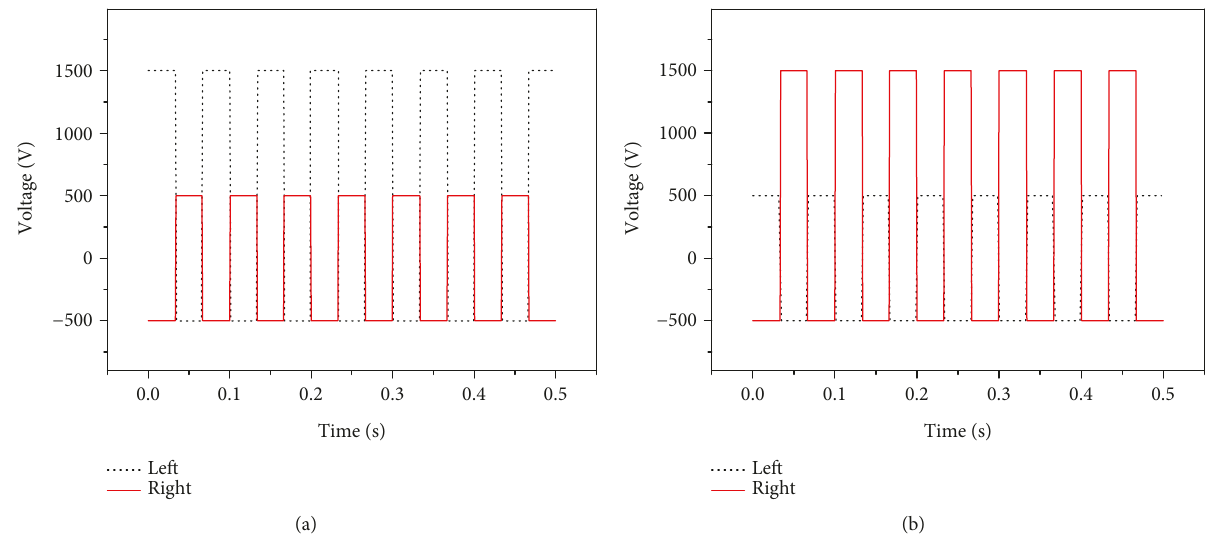
Figure 16: Input voltage signals in square waveform on both MFC actuators at 15 Hz in turning motion. (a) Turning right motion. (b) Turning left motion.